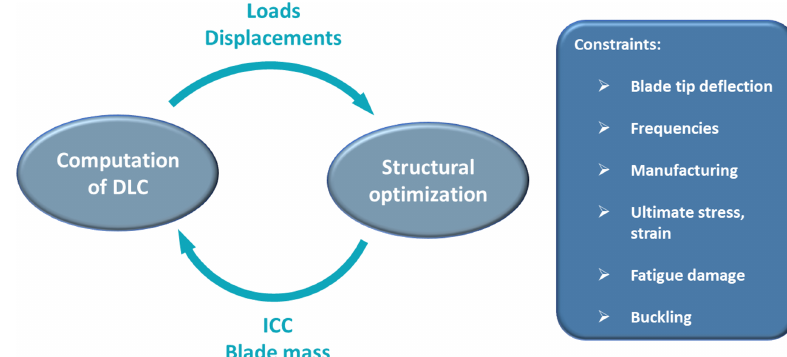
Figure 1. Architecture of the structural design submodule